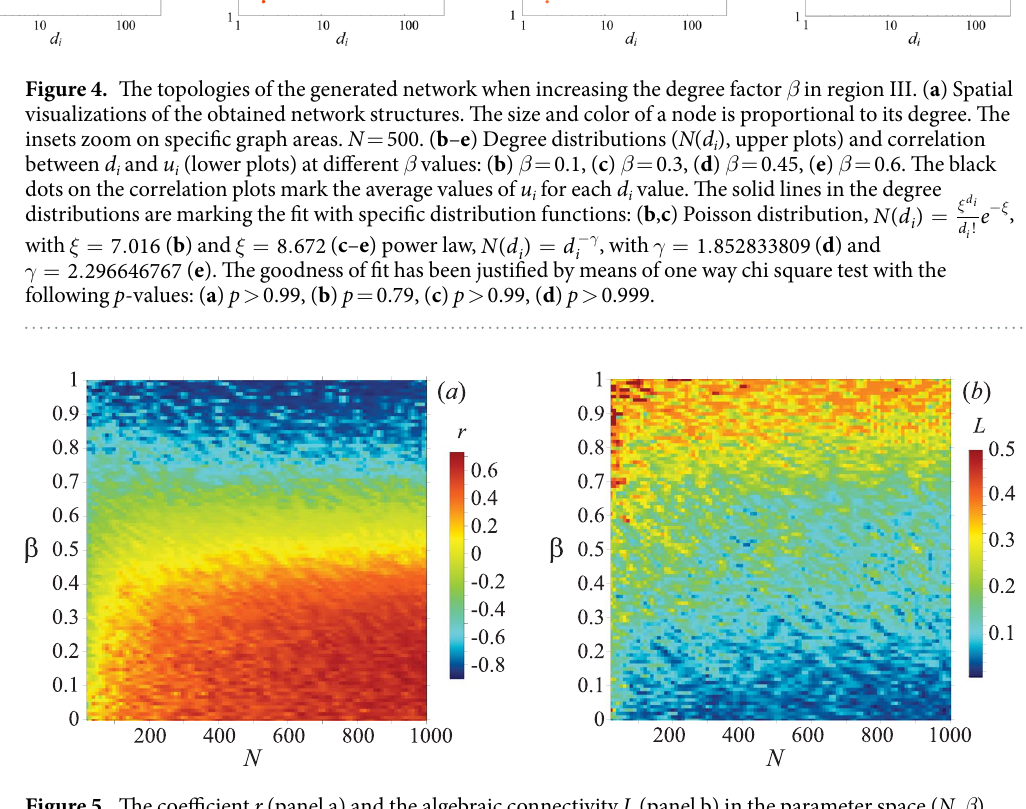
Figure 5. The coefficient r (panel a) and the algebraic connectivity L (panel b) in the parameter space ( N , β ). See main text for definitions. λ =